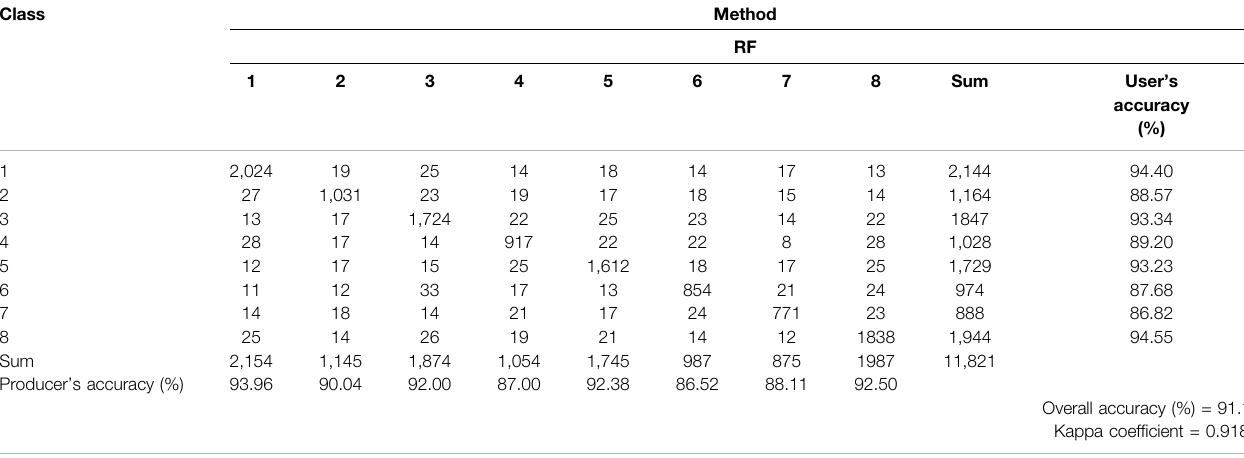
TABLE 4 | Confusion (error) matrix for random forest (RF) classi fi cation. Class